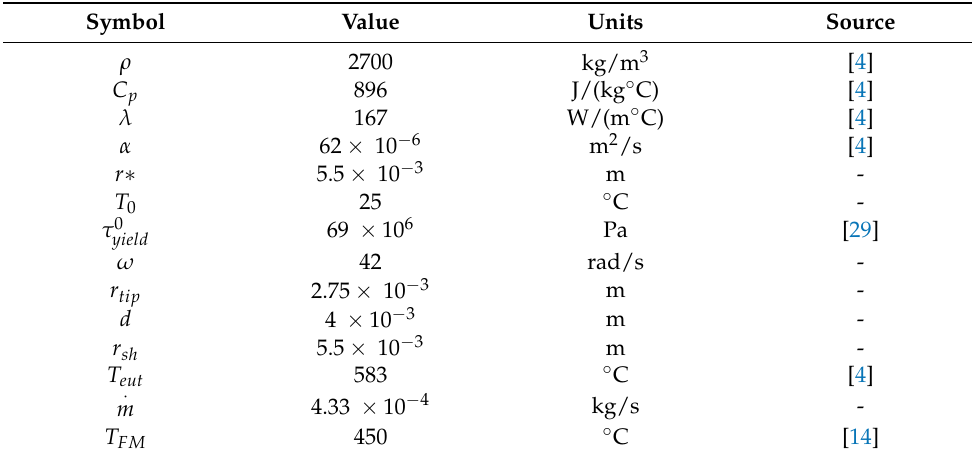
Table 1. Summary of input data used in the semi-analytical model.